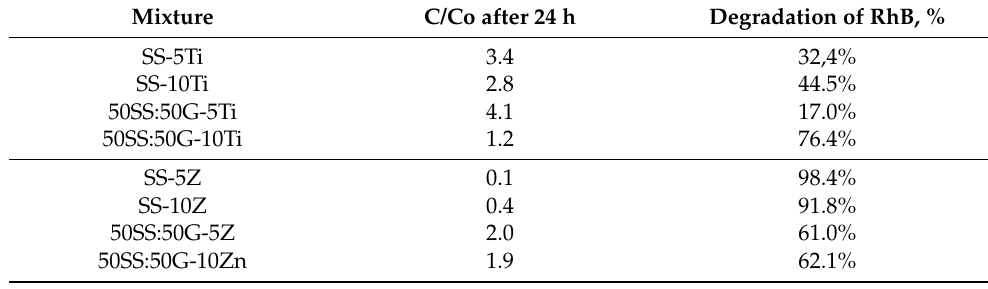
Figure 8. UV − VIS spectrum for different mixtures after 24 h of exposure to RhB with incorporations of ( a ) TiO 2 and ( b ) ZnO particles.